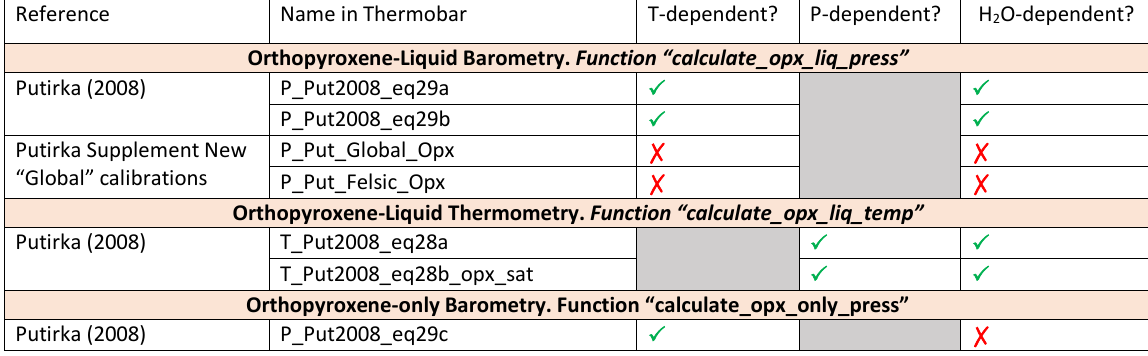
Table A5: Summary of equations for Opx and Cpx-Opx thermobarometry. From: Putirka 2008, Brey and Köhler 1990, Wells 1977, Wood and Banno 1973. The "Global" and "Felsic" orthopyroxene barometers are from the spreadsheets currently available at https://bit.ly/PutirkaSpreadsheets . These equations are particularly suited to low pressure, low-Al orthopyroxenes where other equations return a numerical